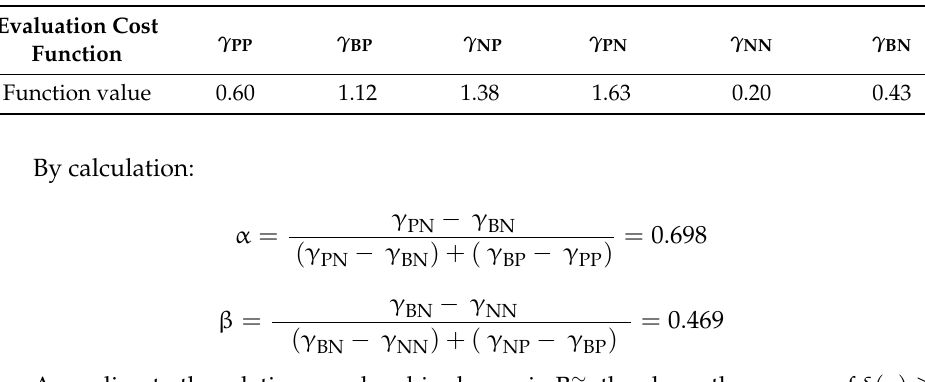
Table 4. Evaluation cost